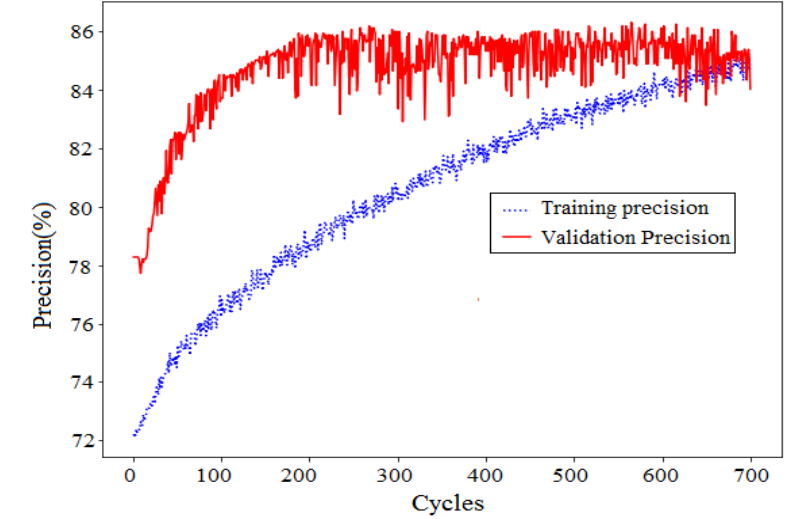
Figure 14. Variation of precision during the learning process of the VGG19 network (maximum precision equal to 86% after 1000